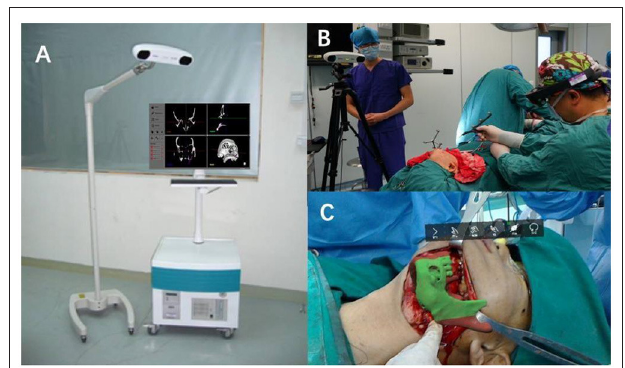
FIGURE 5 | (A) The existing navigation system is a single-point display screen navigation. According to the tomographic image on the display screen, the surgeon needs to imagine the space independently and cannot observe the surgical field and the display screen simultaneously. (B) The working model of the mixed reality navigation system, which can directly display the surgical planning plan and three-dimensional virtual model in the surgical field, and the surgeon can adjust it through voice and gesture operations. (C) The head-mounted device uses the navigator to perform continuous intraoperative temporal and spatial configuration, directly realizing the superimposed display of the patient’s anatomical structure and the virtual model in the surgical